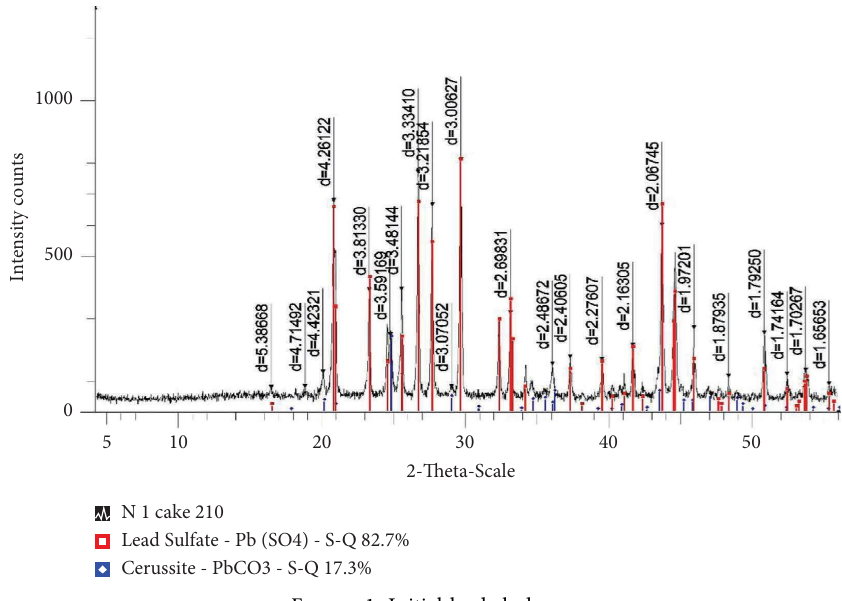
Figure 1: Initial lead sludge.